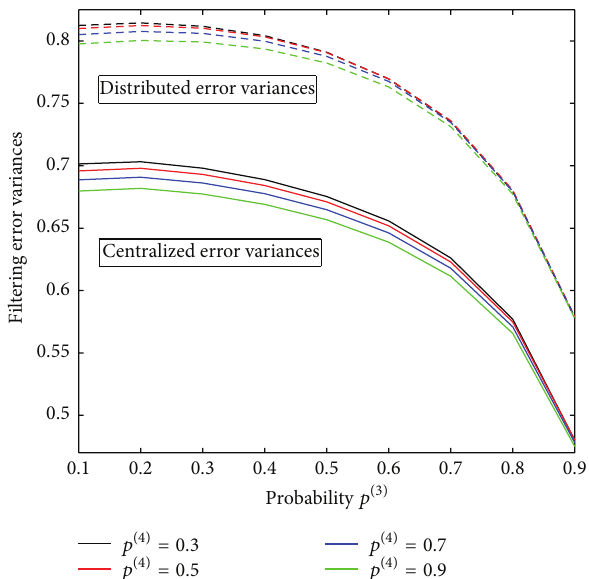
Figure 3: Centralized and distributed filtering error variances at 𝑘 = 100 versus 𝑝 (3) , when 𝑝 (4) = 0.3, 0.5, 0.7 , and 0.9